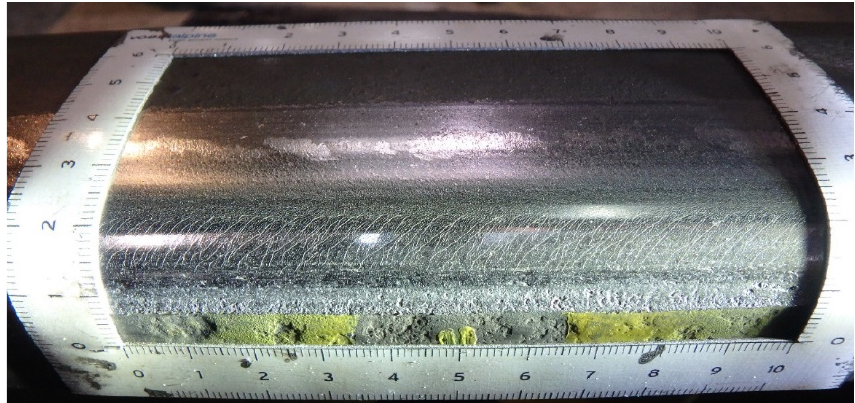
Figure 1. Head check pattern achieved at the end of the RCF experiment in the 1:1 wheel–rail test rig at voestalpine (scales are in cm).